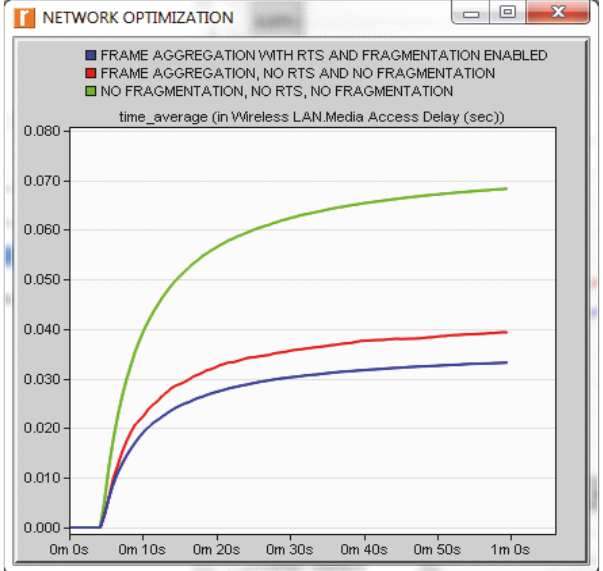
Figure 41: WLAN media access delay with and without RTS and fragmentation